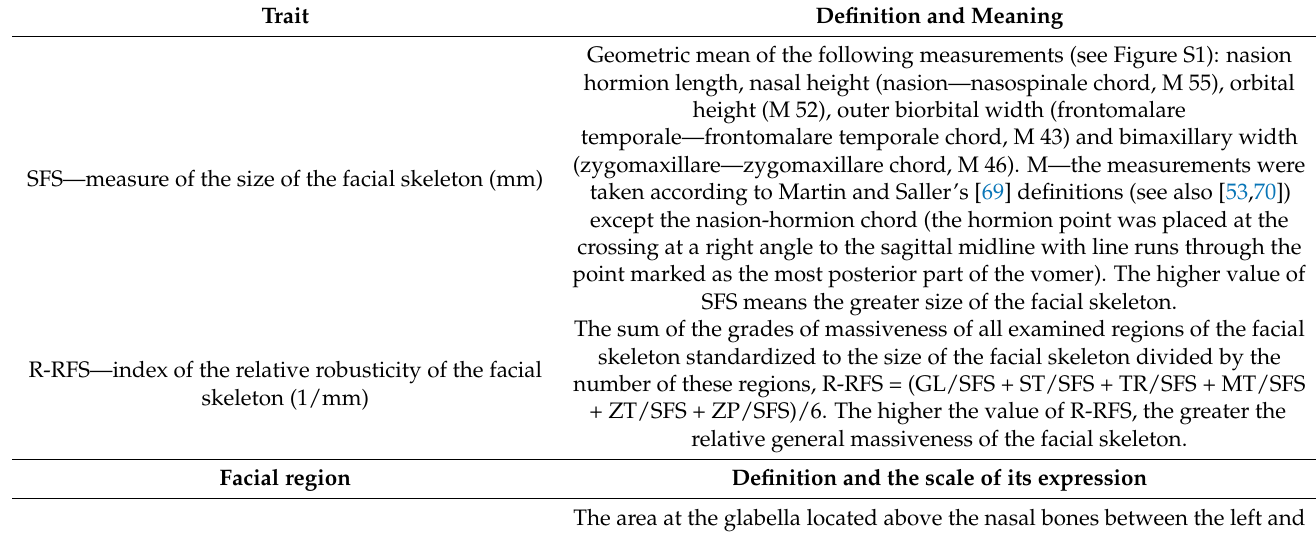
Table 2. Description of the analyzed traits of the facial skeleton and the facial regions assessed in terms of the grades of their